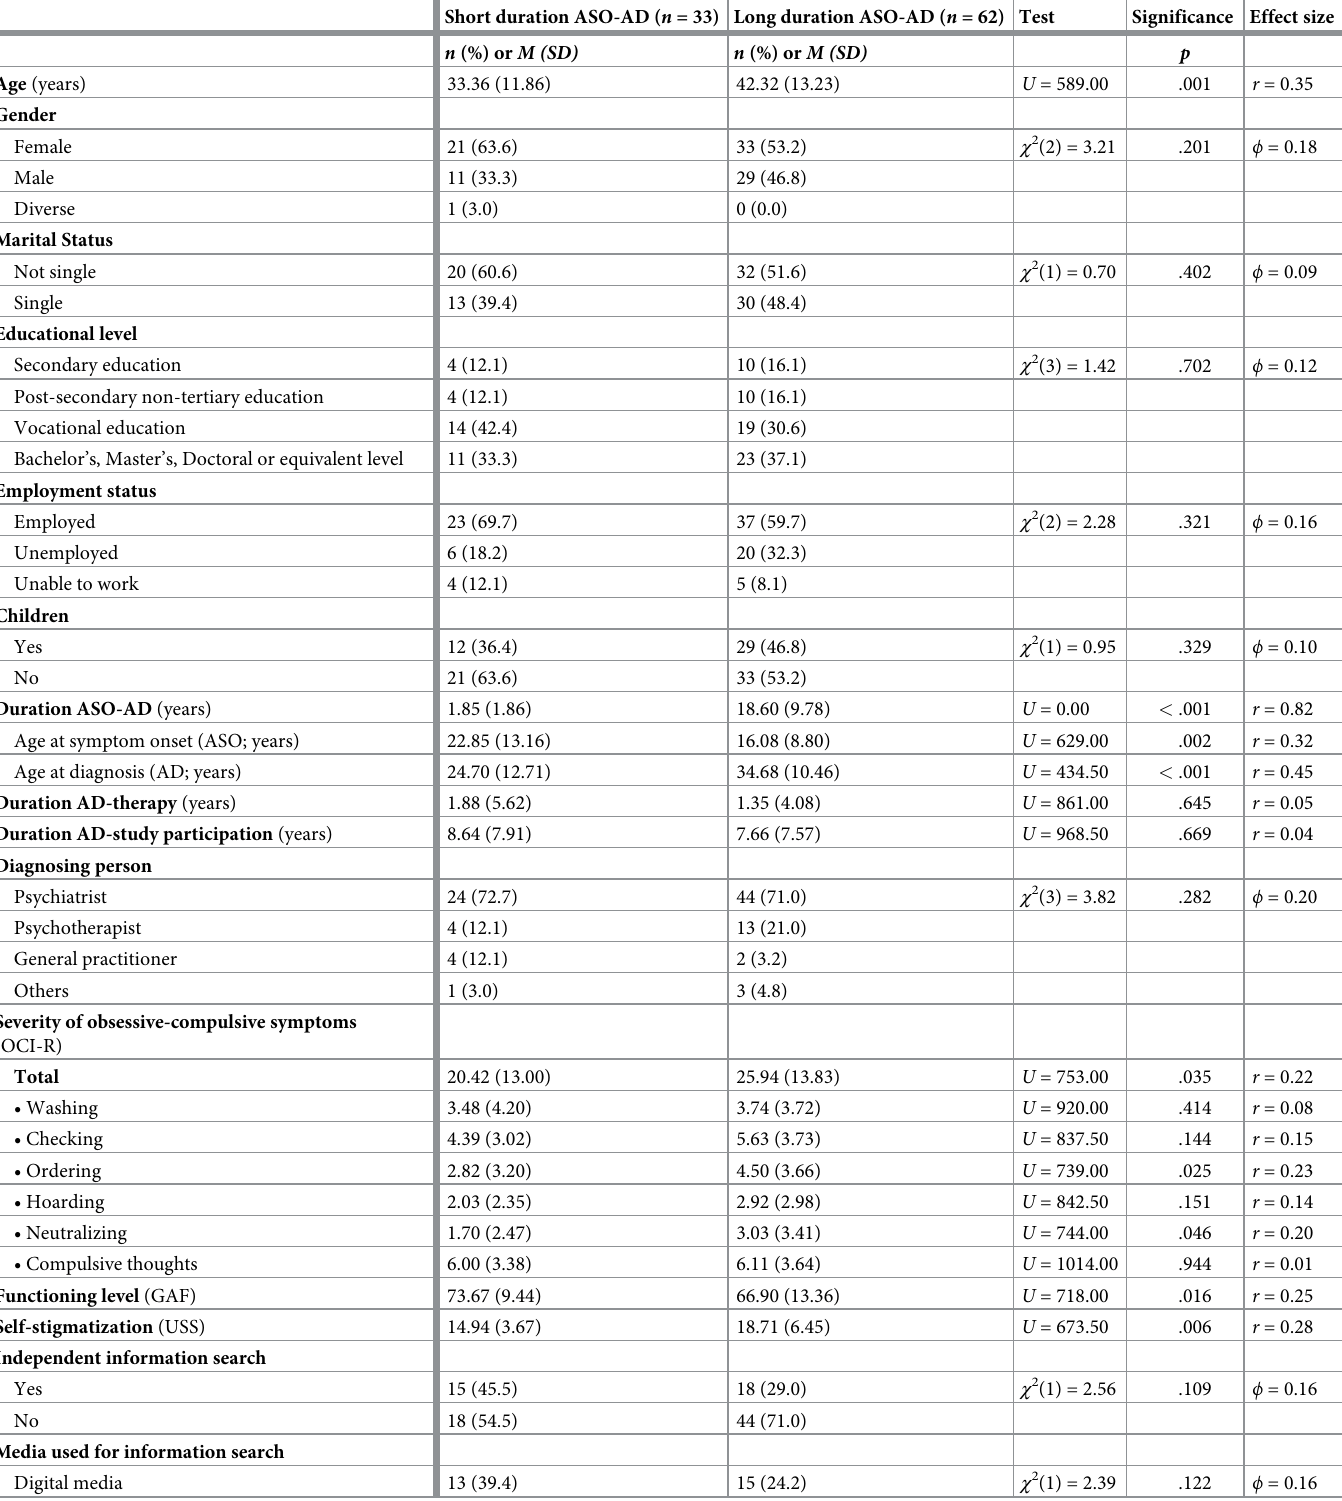
Table 2. Group differences between short and long duration